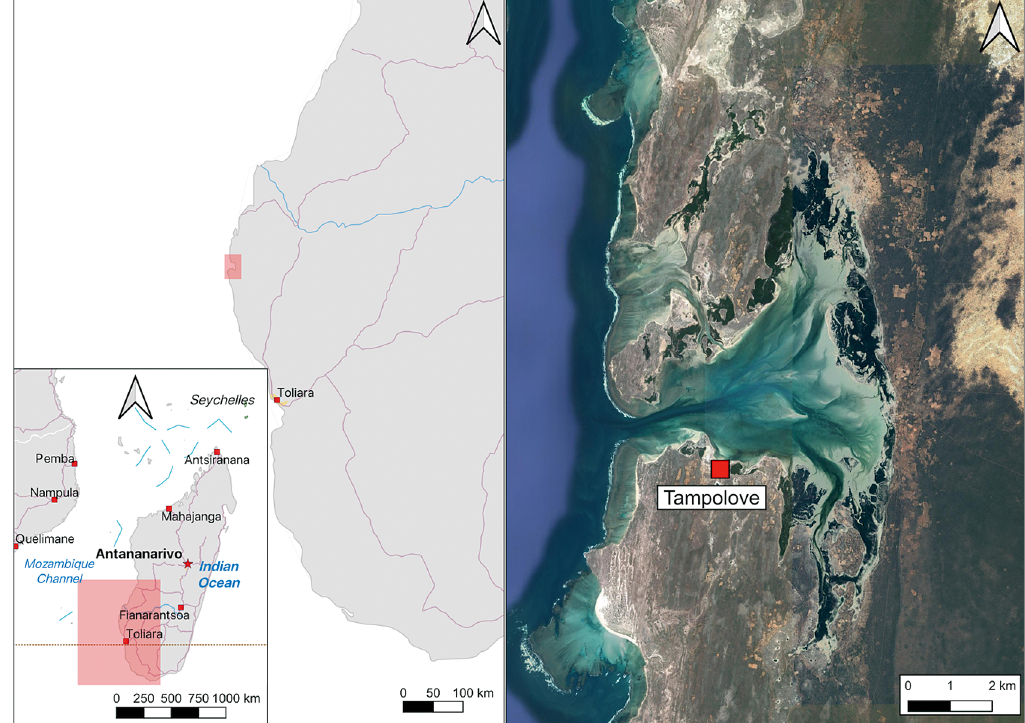
Fig. 1. Location of Tampolove within the Bay of Assassins in southwest